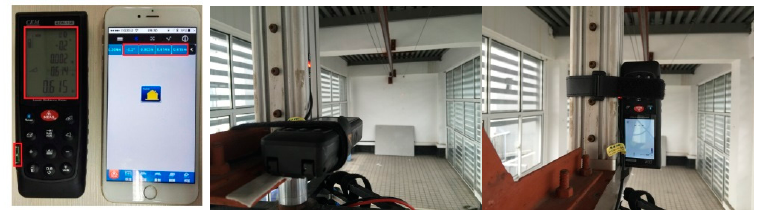
Figure 8. The left photo is the laser distance meter connected with a mobile phone via Bluetooth; the photo on the right shows the laser distance meter installation method.